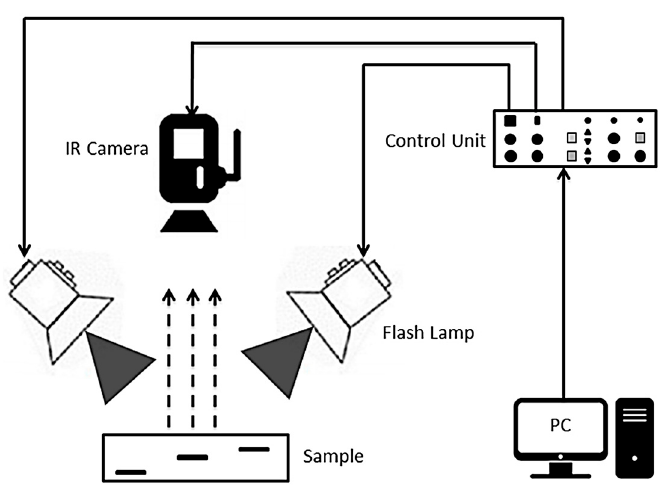
Figure 17. Pulse thermography setup [105].